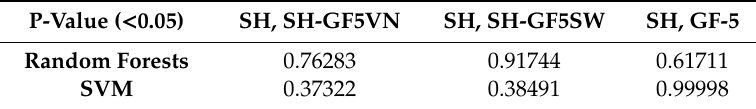
Table 5. The T ‐ test of simulated Hyperion and GF ‐ 5.